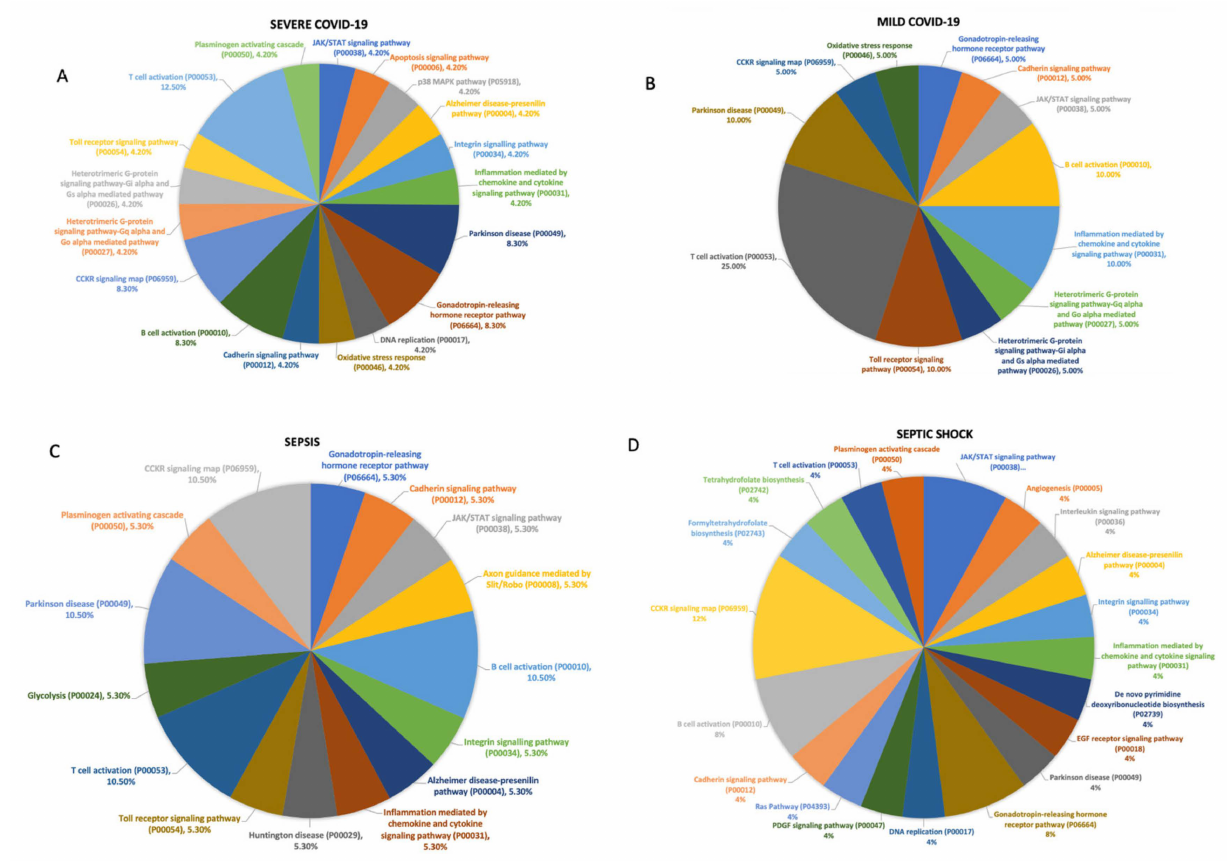
Figure 4. Pathway of the most commonly expressed genes in different cell subtypes across patients. Individually, the unique, most commonly expressed genes in COVID-19 and bacterial sepsis patients with mild and severe disease manifestations, found in Supplementary Material S2, were submitted to the PANTHER software. A pathway involvement analysis of the genes was returned by the software and was later coded into pie charts. T cell activation and the CCKR signaling map were more abundant among the genes of non-severe COVID-19 patients, while patients with the severe form of the disease demonstrated genes that contributed less to the T cell activation pathway ( A , B ). The Parkinson disease pathway to be more abundant in the non-severe form of the disease ( C ). The angiogenesis pathway was significantly enriched in patients with severe forms of sepsis (i.e., septic shock) ( D